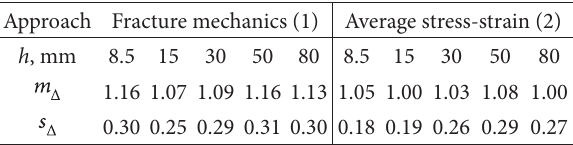
Table 3. Basic statistics derived for both tension-stiffening approaches after scaling Approach Fracture mechanics (1)